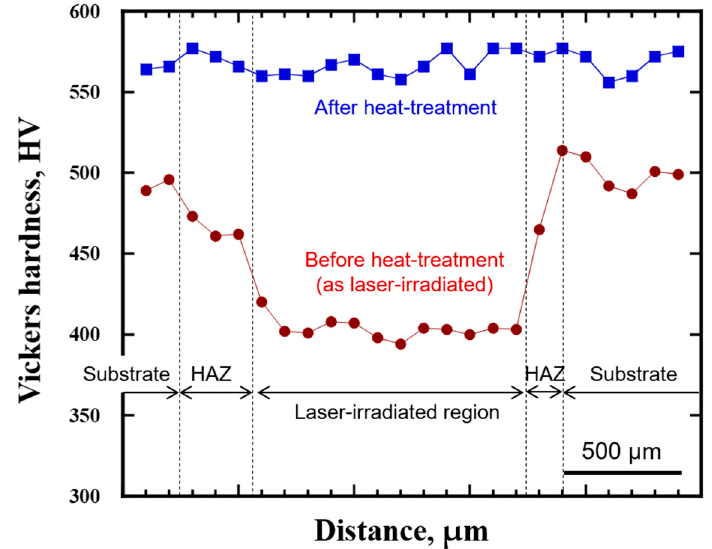
Figure 8. Vickers hardness line profile across the laser-irradiated region of the Ni-9 at.% Al-16 at.% V alloy specimens before and after heat treatment at 980 °C for 1 h.